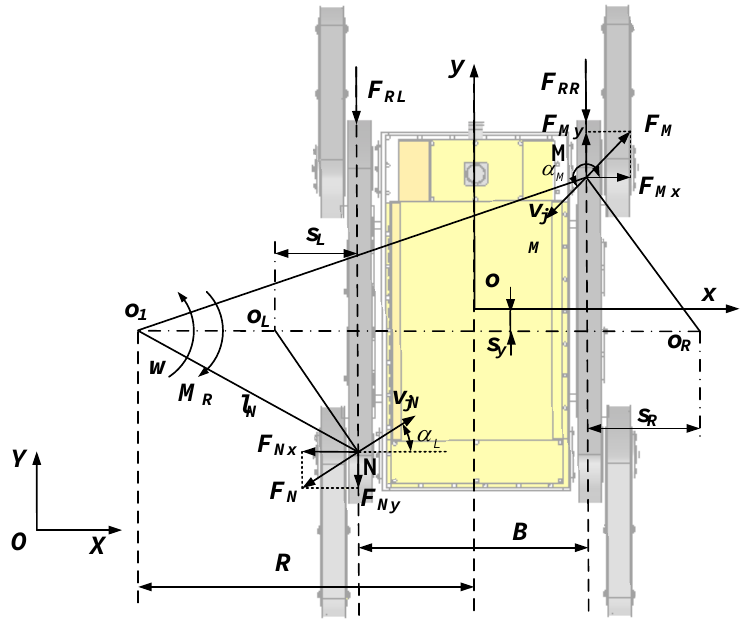
Figure 2. Analysis diagram of robot steering force.